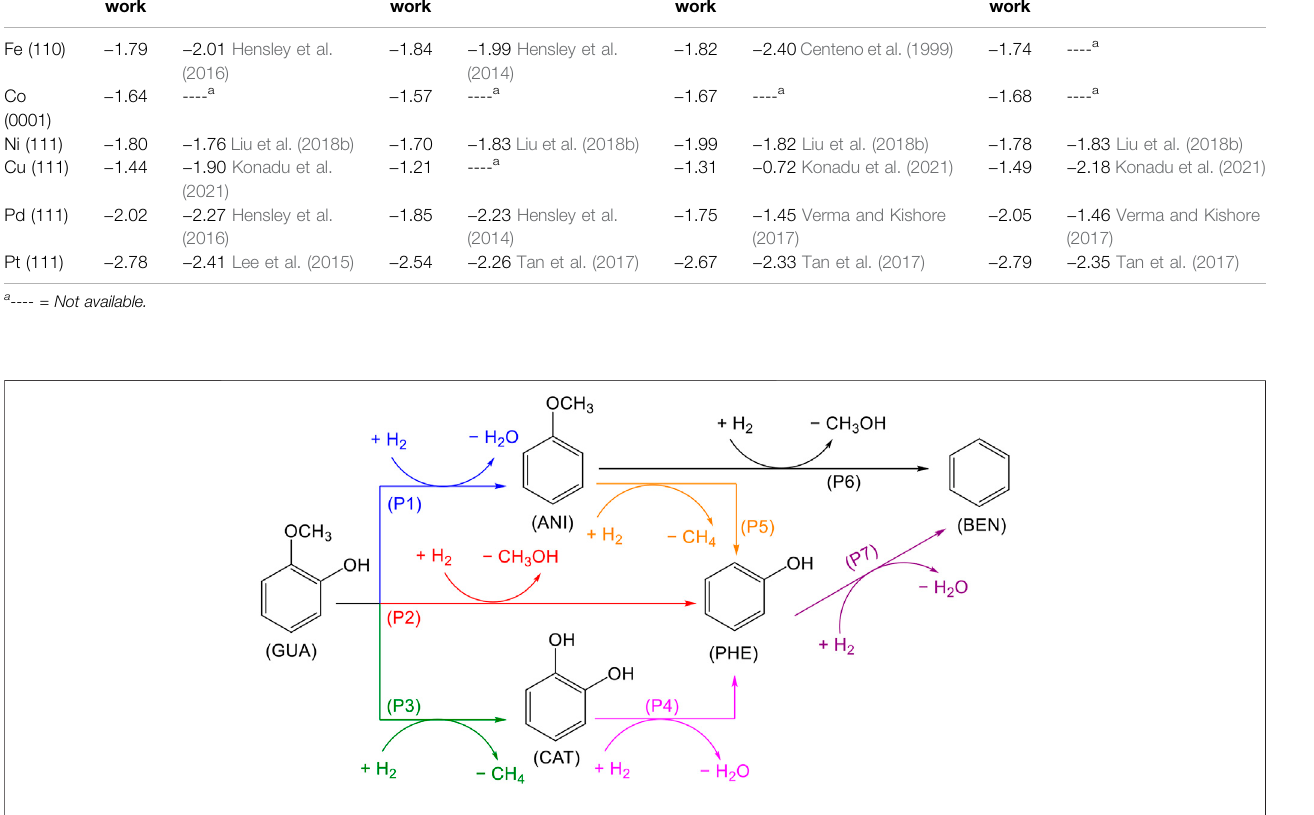
SCHEME 1 | Proposed reaction network for the guaiacol